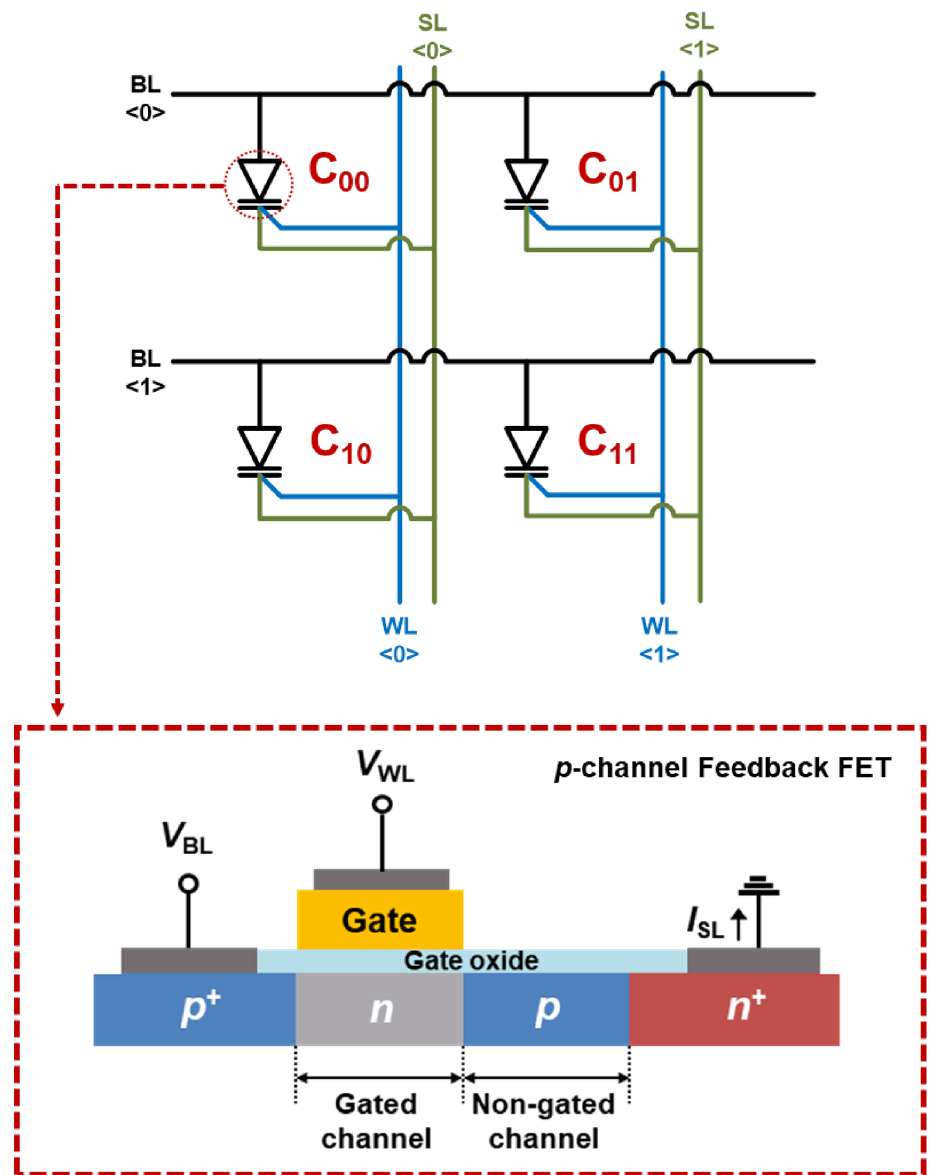
Figure 1. Schematics of a 2 × 2 array of 1T-SRAM cells and a p -channel